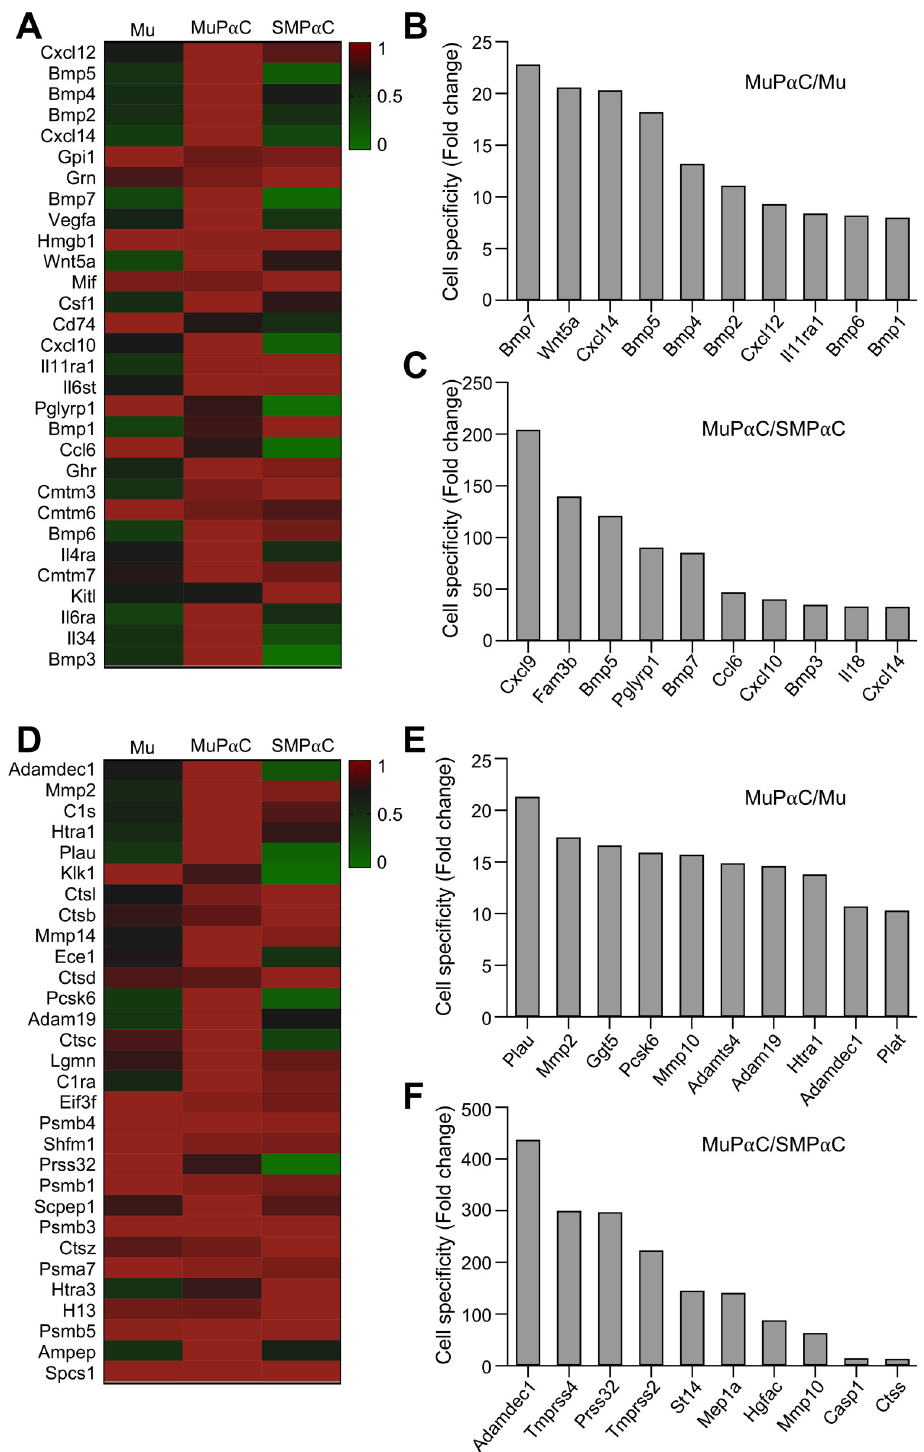
Fig 7. Identification of the cytokines and peptidases predominantly expressed in colonic MuP α C. A : A heat map of the cytokines enriched in MuP α C compared to mucosal tissue (Mu) and smooth muscle PDGFR α + cells (SMP α C). Sorted by MuP α C/Mu, cut off 10 fold MuP α C in MuPaC/Mu; sorted by MuP α C/SMP α C cut off 10 fold MuP α C and 1 fold SMP α C in MuP α C/SMP α C. B : Cytokines enriched in MuP α C compared to colonic SMP α C. C : MuP α C-specific cytokines compared to SMP α C. D : A heat map of the peptidases enriched in MuP α C compared to Mu and SMP α C. E :